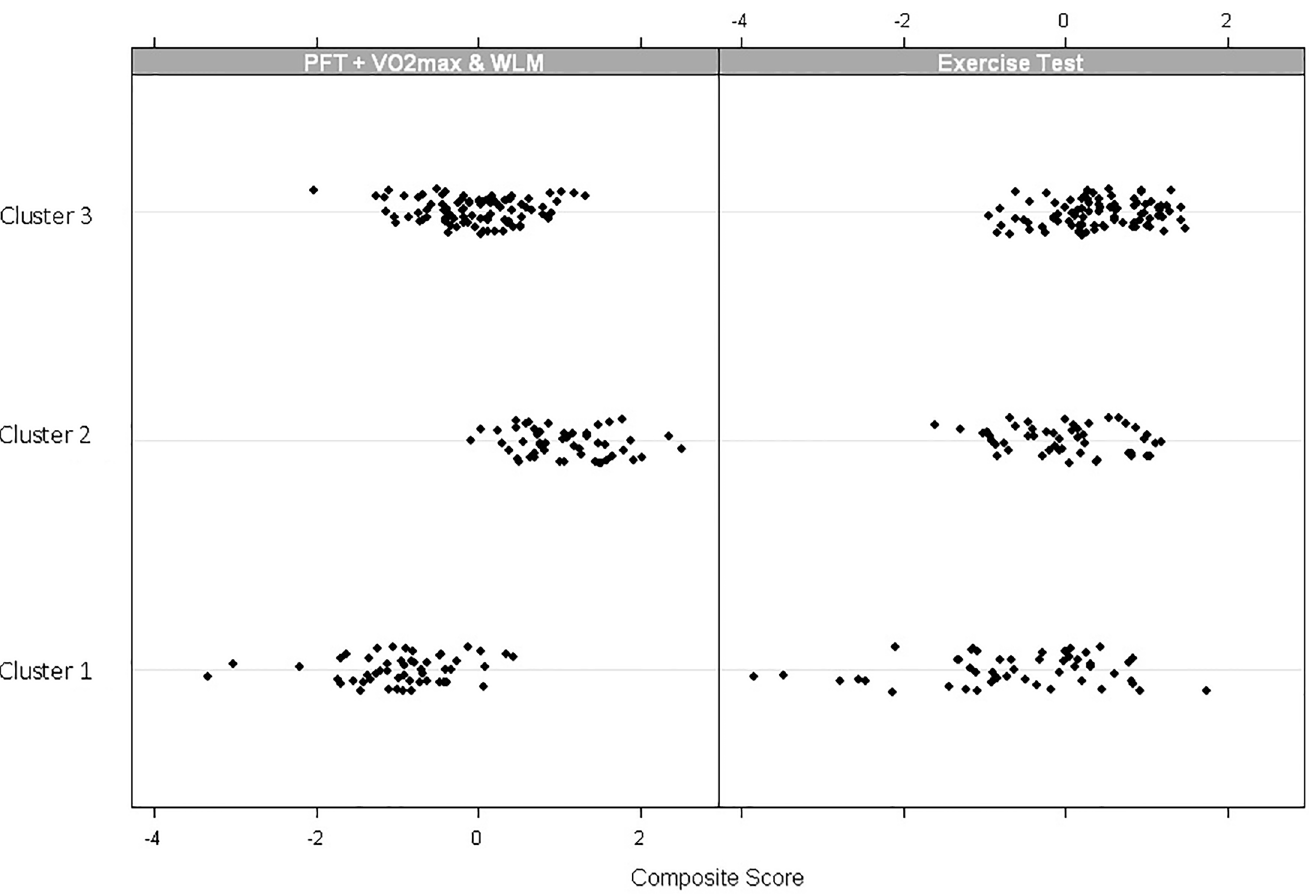
Fig 1. Comparison of factors between clusters. Cluster 1 had significantly lower composite scores than Clusters 2 or 3 (p < 0.0001). Cluster 3 had significantly lower PFT, VO 2 m + WLM composites than Cluster 2 (p <